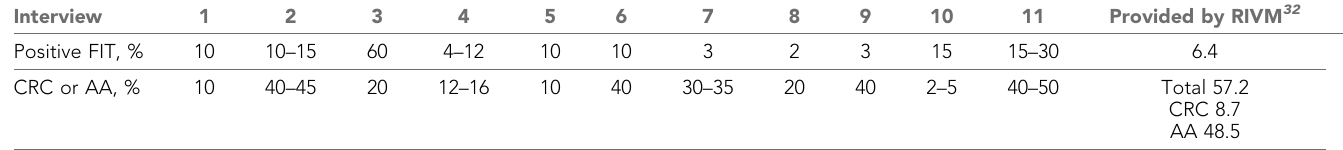
Table 2. GPs’ estimations: percentage of positive FIT results and combined probability of CRC and AA